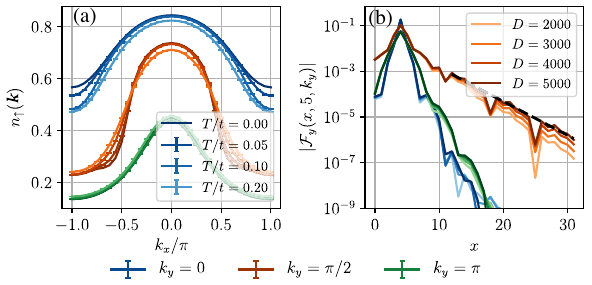
FIG. 5. (a) Momentum distribution function n ↑ ð k Þ of the 32 × 4 square cylinder at U=t ¼ 10 for p ¼ 1 = 16 . (b) Ground-state single-particle correlation function from DMRG after Fourier transform in the y direction, F y ð x l ; x m ; k y Þ . At k y ¼ π = 2 , we observe a slow exponential decay hinting toward a small charge gap at this wave